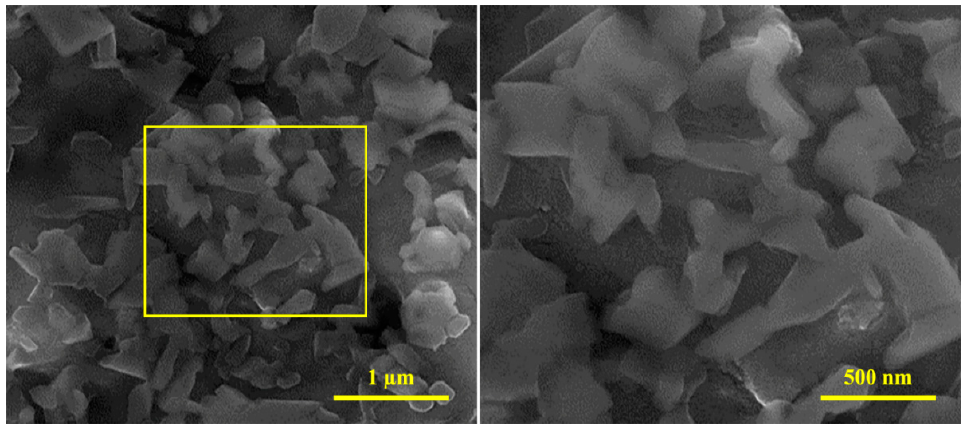
Figure 3. FESEM micrographs showing the size of the diopside (DIO) particles magnification at different magnification.